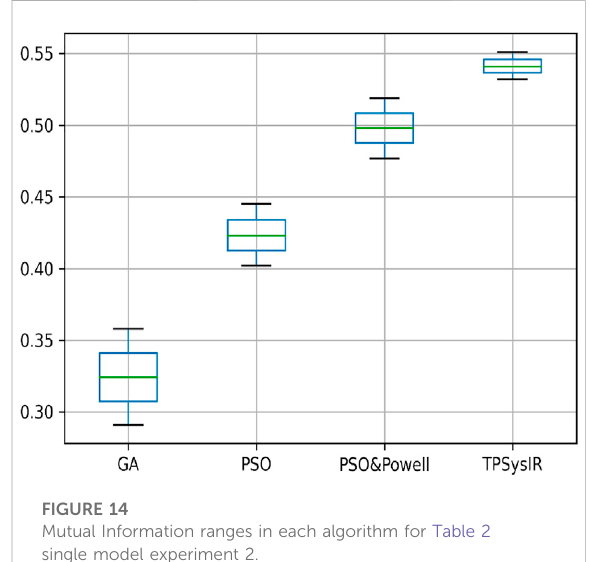
FIGURE 16 Mutual Information ranges in each algorithm for Table 2 Multimodal Experiment 2.